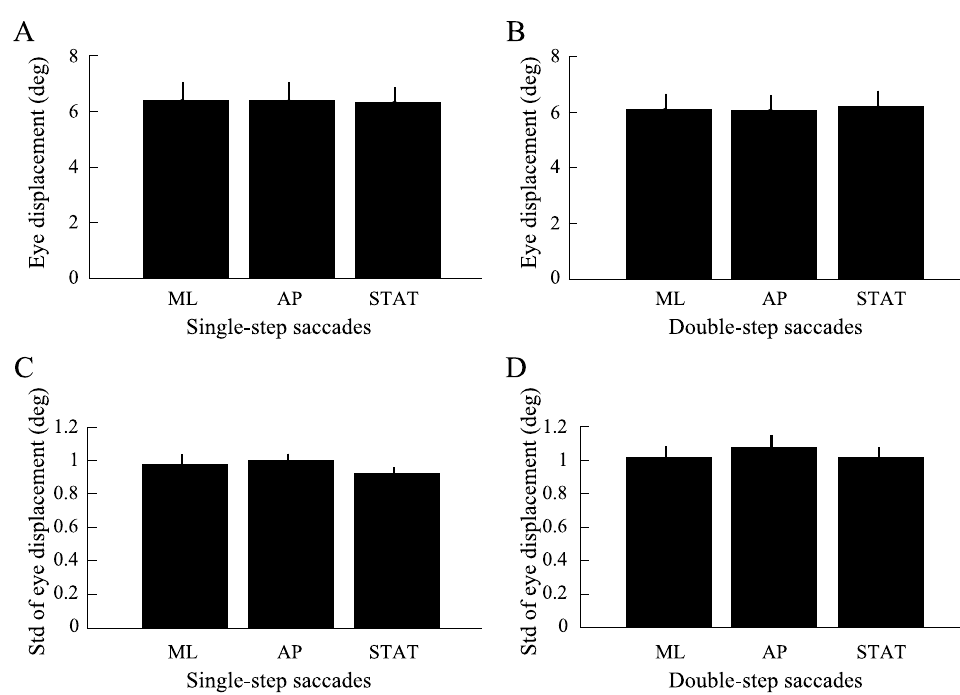
Fig 3. Eye movement results. Accuracy (A,B) and precision(C,D) of eye displacements as a function checkerboard stimulus movement in the single- step (A,C) and double-step (B,D) saccade conditions. Displacement data is plotted with respect to the central gaze target position. Data from all subjectsand trials was pooled.Error bars = standarderror of the mean. ML = mediolateral,AP = anteroposterior, STAT =